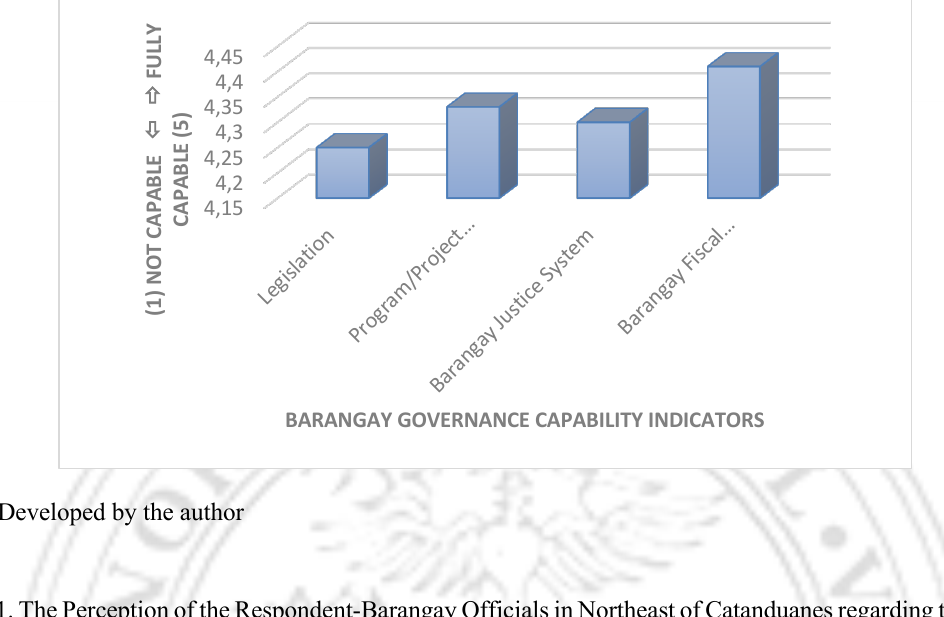
Figure 1: Over-all Barangay Captain’s Governance Capabilities